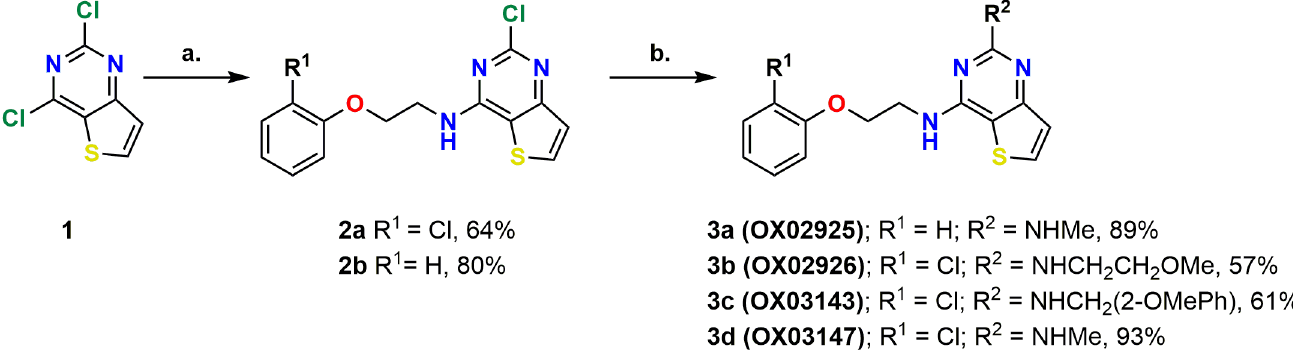
Fig 2. Synthetic route to putative hit compounds. (a) Substituted 2-phenoxyethan-1-amine (1.0 equiv.), DIPEA (2.0 equiv.), 1,4-dioxane, 80˚C, 3 hours. (b) Alkyl amine (10.0 equiv.), i PrOH, 100˚C, 16–24 hours.